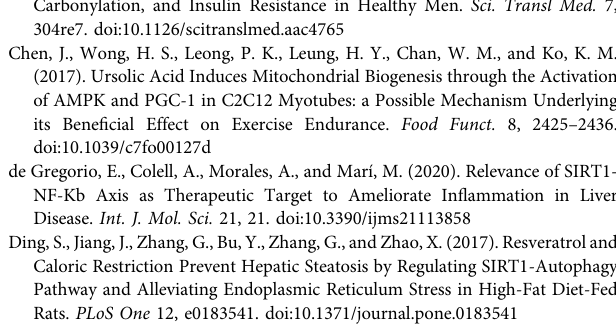
Figure Supplementary S1 | NAC treatment upregulated the expression level of antioxidant enzyme and triglyceride metabolism enzymes but showed little effect on